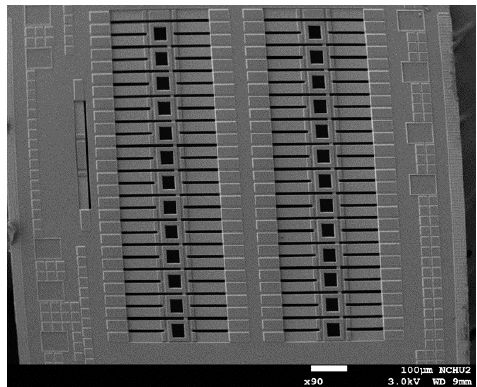
Figure 9. TEMH image taken by SEM.